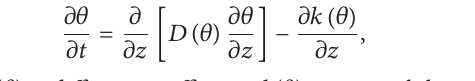
Figure 1: SWCC of sand